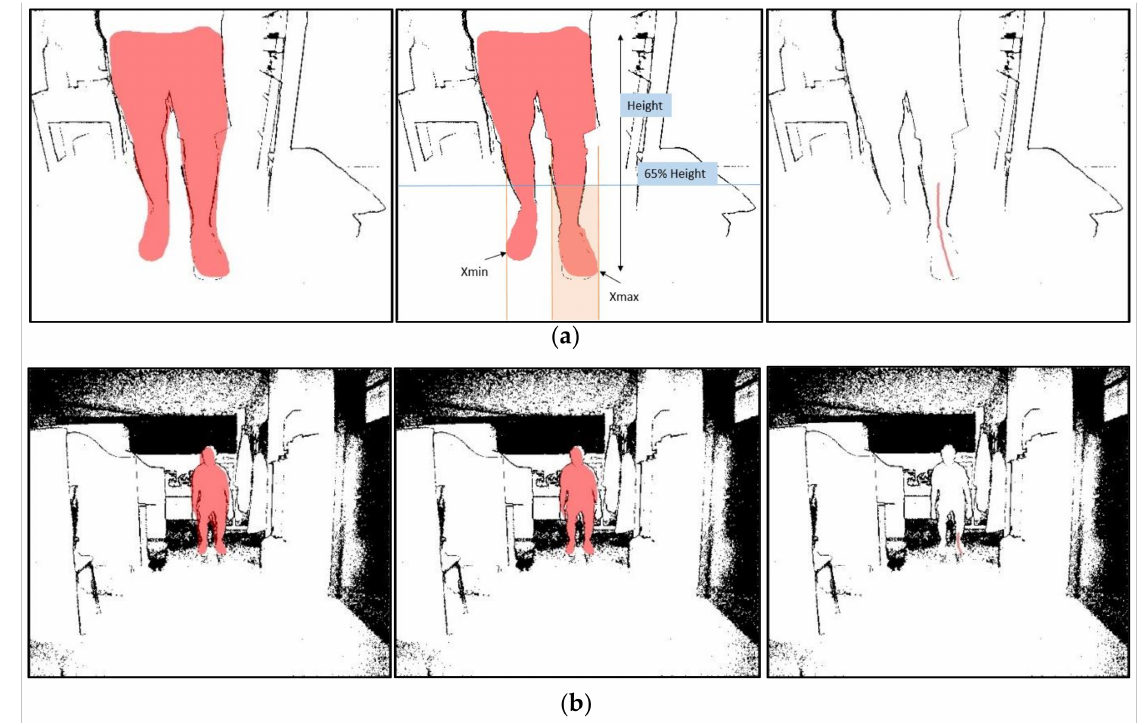
Figure 12. Example of two images processed to obtain the projection line on the ankle for ( a ) distance: 1 m ( b ) distance: 4 m. For each of one, it shows the mask transferred from the RGB image ( left ), the mask processed to improve the fit of the body by distance discrimination ( center ), and finally the resulting projection line ( right